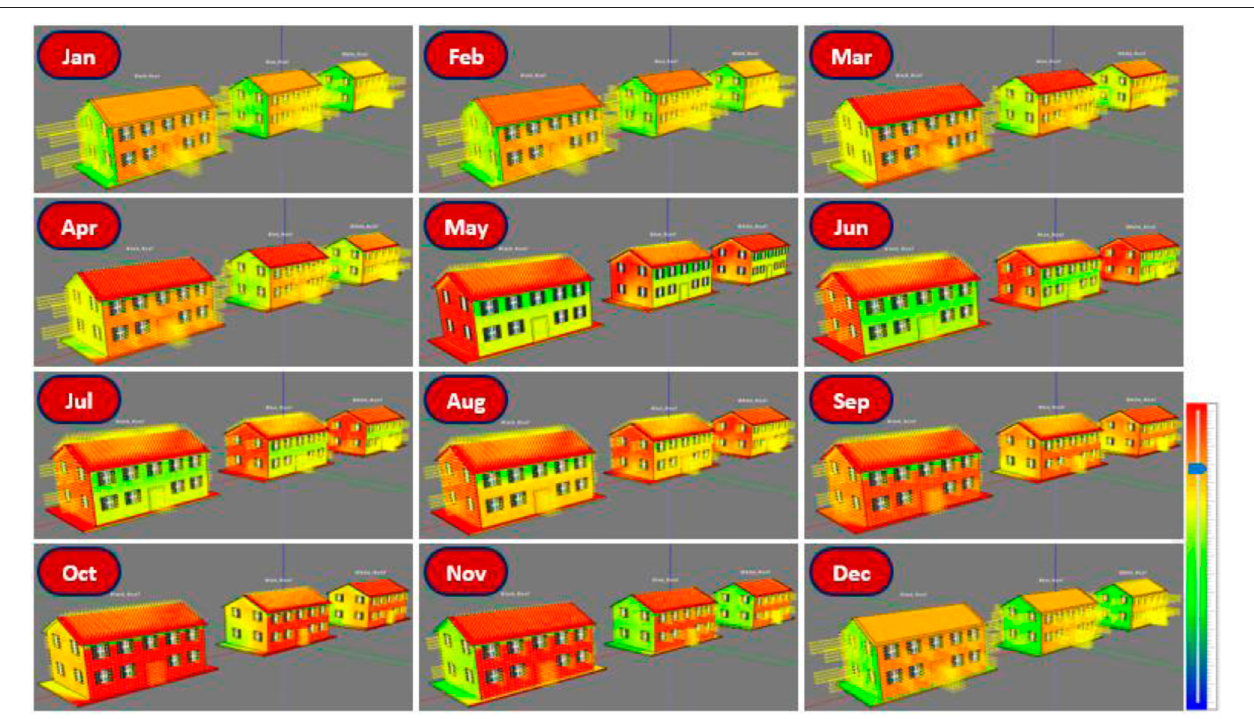
FIGURE 5 | The three buildings with the different roof colors ’ energy gain map from January till December.